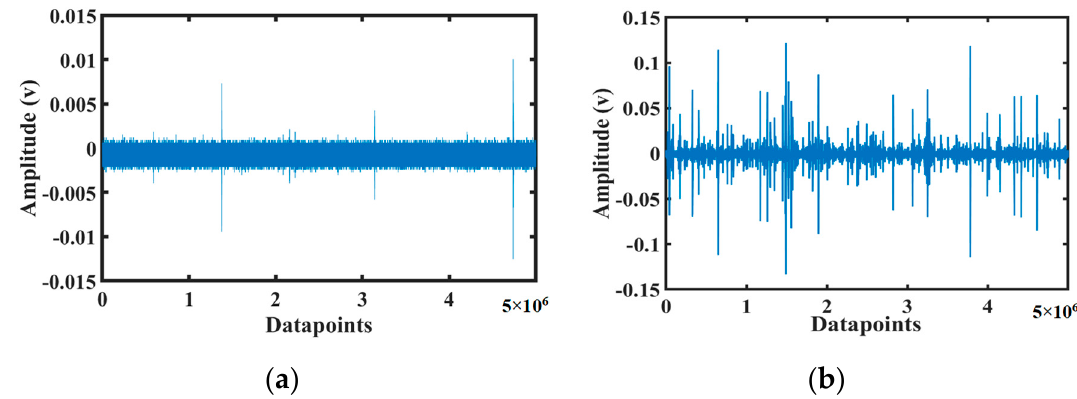
Figure 4. Collected noisy AE signals from the three-point bending test: ( a ) normal condition and ( b ) abnormal condition.